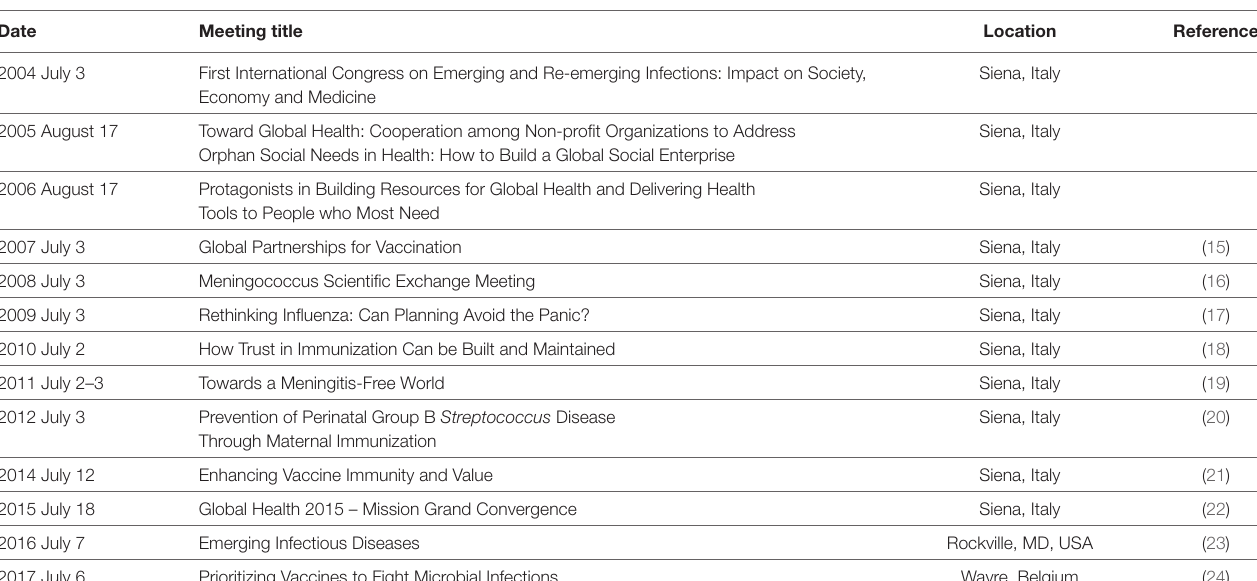
TABLe 2 | The Palio Meetings during the